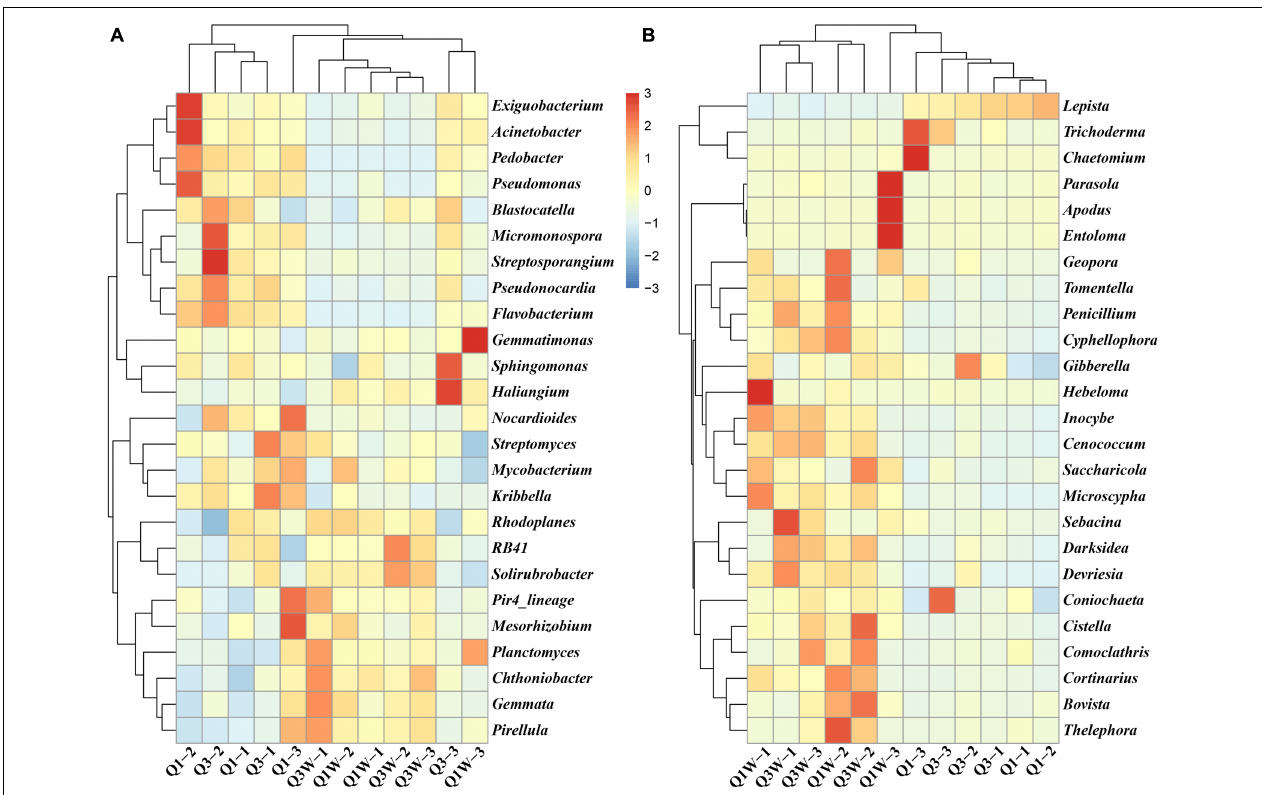
FIGURE 3 | Heatmap displaying the relative abundances of the most dominant genus, the relative abundance of species in at least one sample is above 0.1% (top 25) in each sample. The dendrogram represents complete-linkage agglomerative clustering, based on Euclidean dissimilarities. (A) bacteria; (B) fungi.